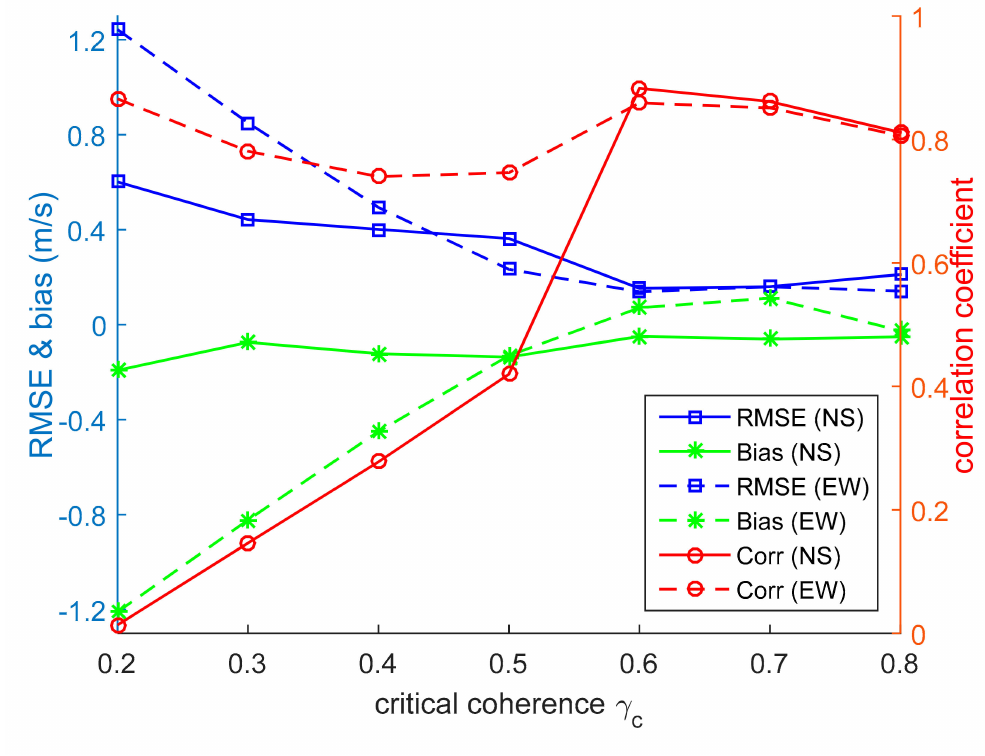
Figure 8. The RMSE, bias, and correlation coe ffi cient between the current velocities measured by a current meter and those retrieved from X-band marine radar images with di ff erent critical